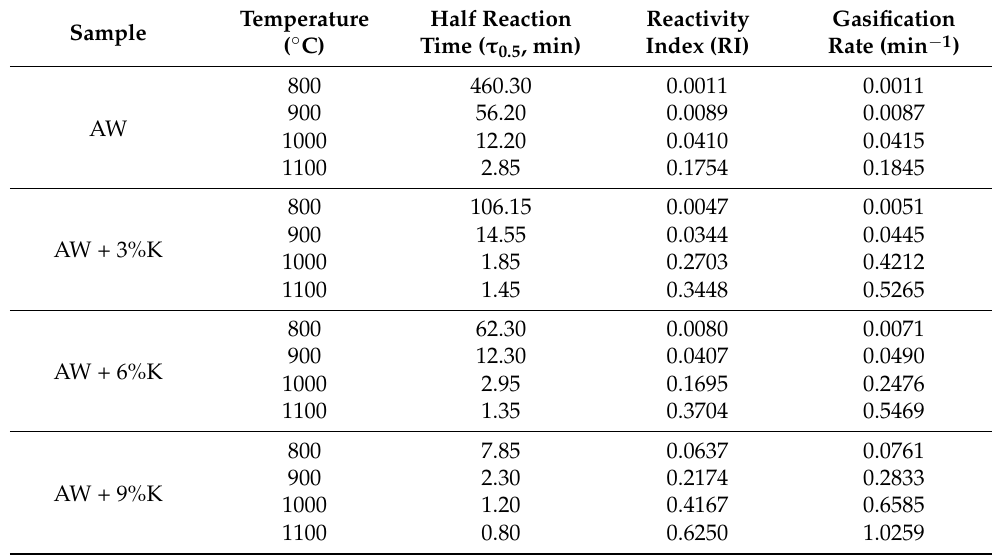
Figure 2. Effects of KCl concentration on char gasification at different constant temperatures (800 ◦ C, 900 ◦ C, 1000 ◦ C, and 1100 ◦ C). Table 2. Effects of KCl concentration on the characteristic parameters of char gasification.